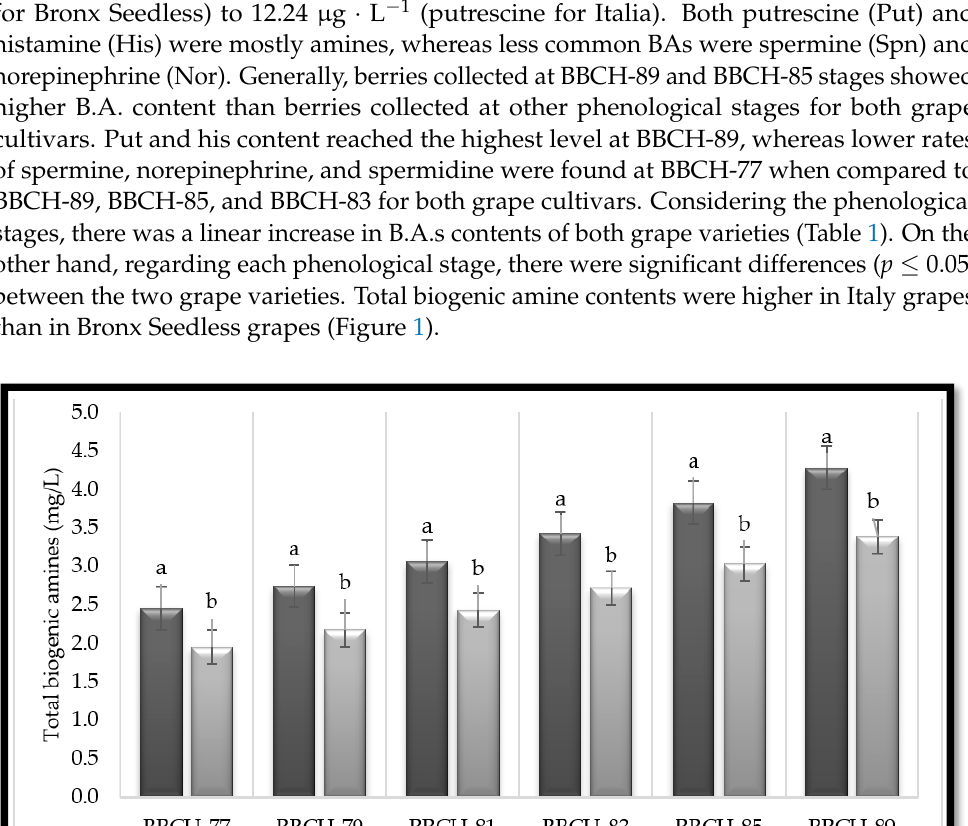
Table 2. Pearson correlation between biogenic amines in grape varieties. Significant correlations are reported for 0.01 < p < 0.05 (**) and p < 0.01 (*).The color intensity is proportioned to the Pearson Index.